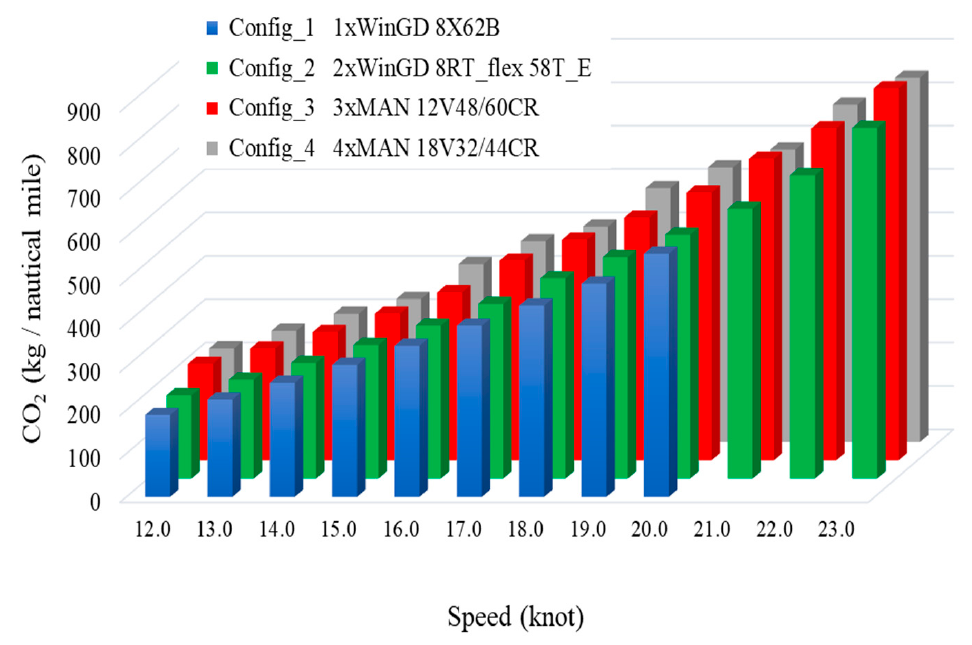
Figure 17. CO 2 emissions as a function of navigation speed.